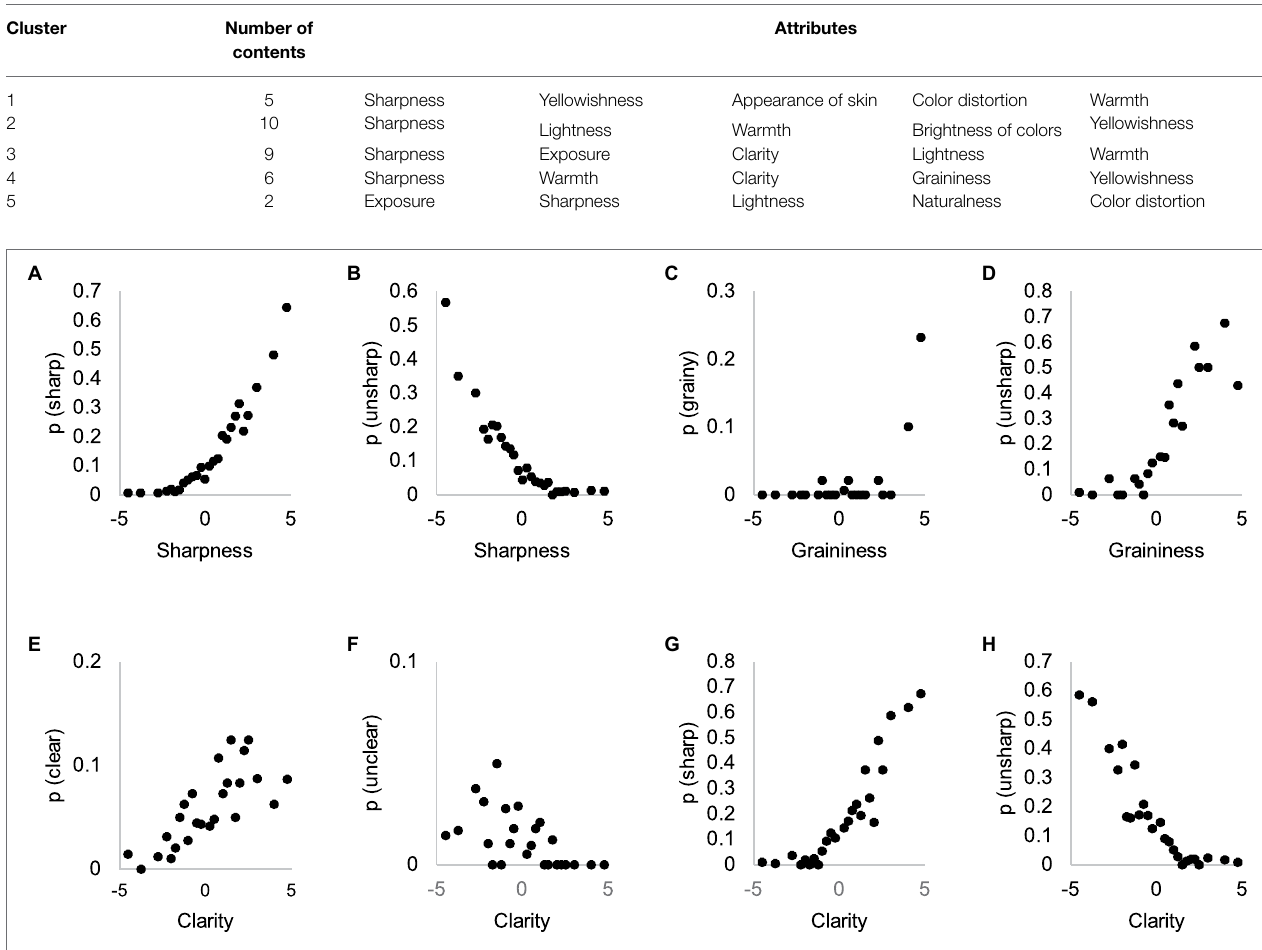
TABLE 3 | Attributes selected to Experiment 2 in each content cluster, derived from Experiment 1.